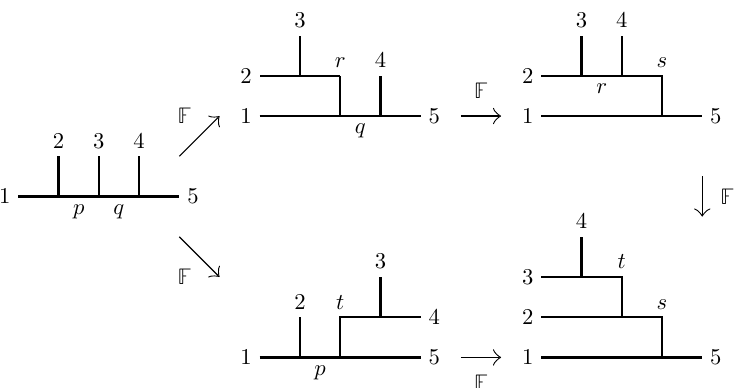
Figure 8 . The sequence of crossing moves applied to the sphere (cid:12)ve-point conformal block leading to the pentagon identity (5.4) for the fusion